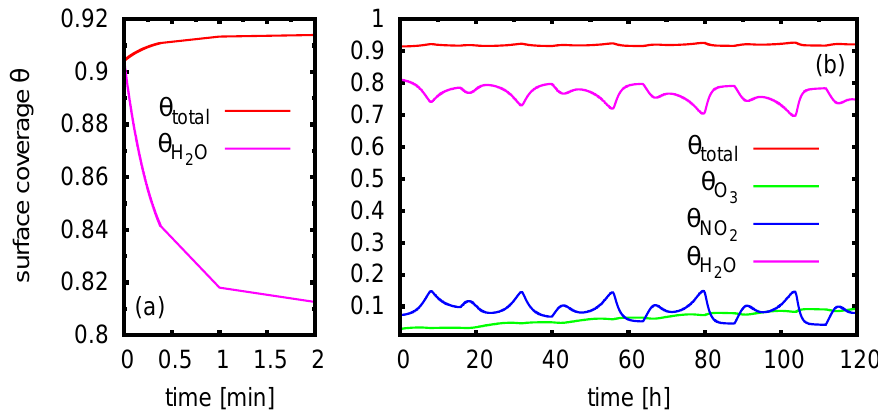
Fig. 3. The temporal evolution of the soot surface coverage θ in scenario C is shown for the first 2min (a) , and for the entire simulation period of five days (b) . The total surface coverage is indicated by θ total , and the fractional surface coverages of O 3 , NO 2 , and H 2 O by θ O 3 , θ NO , and θ H , respectively. Input parameters and surface reactions for scenario C are given in Table 1.